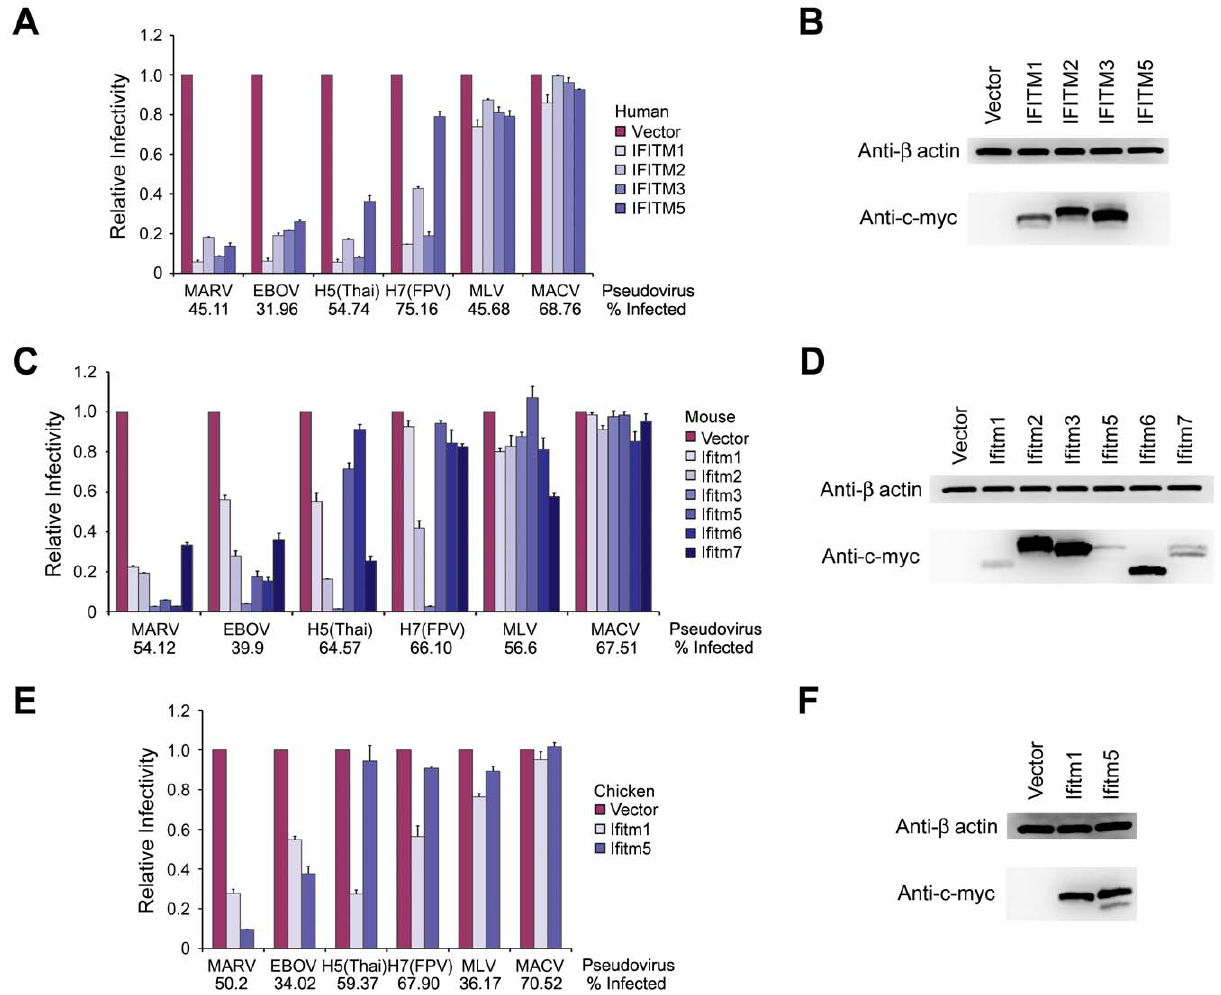
Figure 5. Murine and chicken IFITM orthologs differentially restrict infection mediated by MARV, EBOV, and IAV entry proteins. A549 cells were transduced to express the indicated c-myc-tagged ( A ) human, ( C ) mouse, or ( E ) chicken IFITM orthologs. Two days later, cells were infected with MLV-GFP pseudotyped with the indicated viral entry glycoproteins. Pseudovirus infection was measured by flow cytometry, and normalized to that of cells transduced with vector alone. Expression of ( B ) human, ( D ) mouse, or ( F ) chicken IFITM protein orthologs in A549 cells assayed in (A), (C), and (E), respectively was measured by western blot using the anti-c-myc antibody (9E10). All differences in pseudovirus entry between control and IFITM-expressing cells are significant ( P , 0.05) except for H5(Thai) entry into murine Ifitm6- and chicken Ifitm5-expressing cells, and for H7(FPV) entry into murine Ifitm1- and Ifitm5-expressing cells. Each panel of the figure represents at least two experiments with similar results.